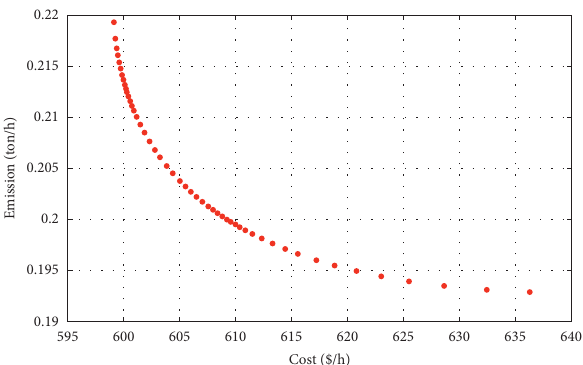
Figure 9: Compromising 50 alternatives from the Pareto set.